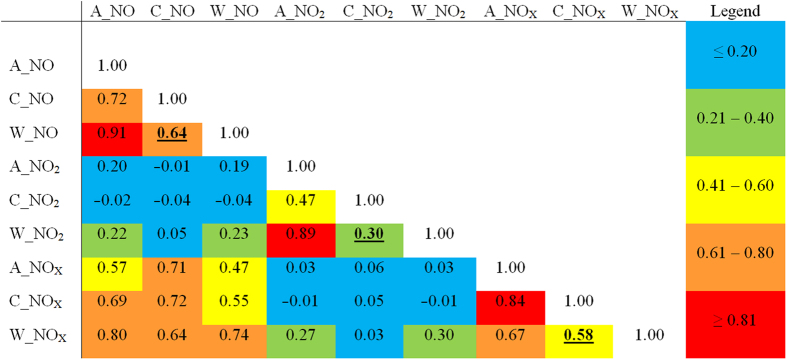
The Spearman correlation coefficients between the annual (A), cooler season (C), and warmer season (W) predicted concentrations across 1000 random locations for NO, NO2, and NOx in 2010, Tehran, Iran. The seasonal comparisons (C vs W) are bold underlined.